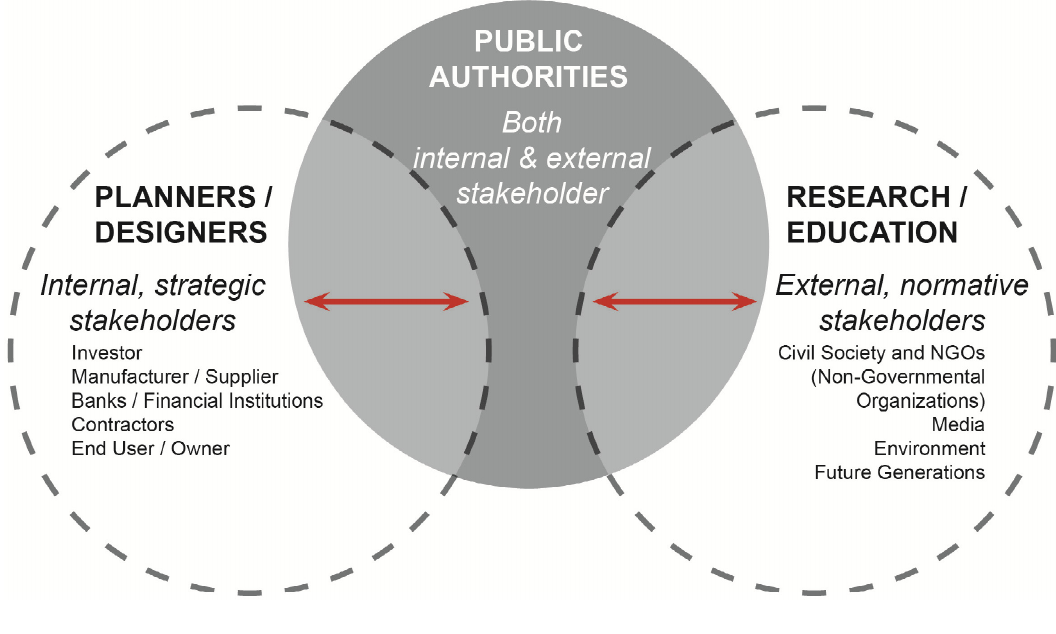
Figure 1. Key stakeholders and stakeholder types from Feige et al.